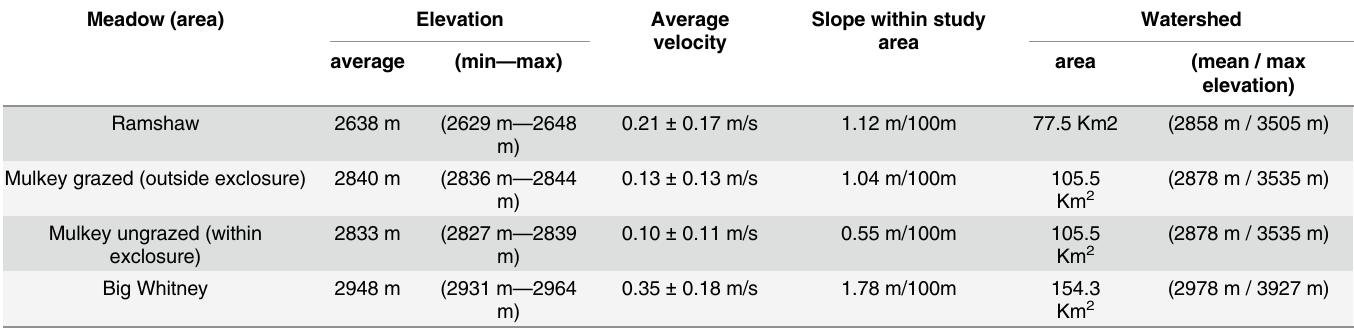
Table 1. Meadows